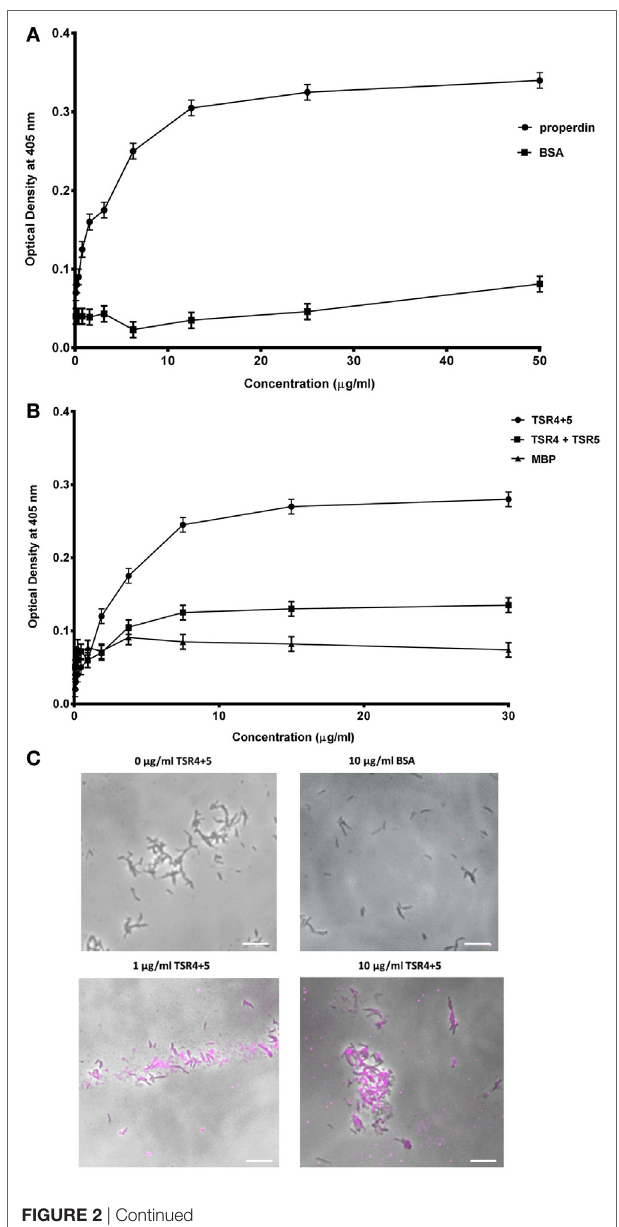
FigUre 2 | Human properdin binds mycobacteria via thrombospondin repeats (TSR) 4 + 5. (a) Properdin binding to mycobacteria; BSA was used as a negative control protein. (B) Comparison between TSR4 + 5 and individual TSR4 and TSR5 binding to mycobacteria; maltose-binding protein (MBP)